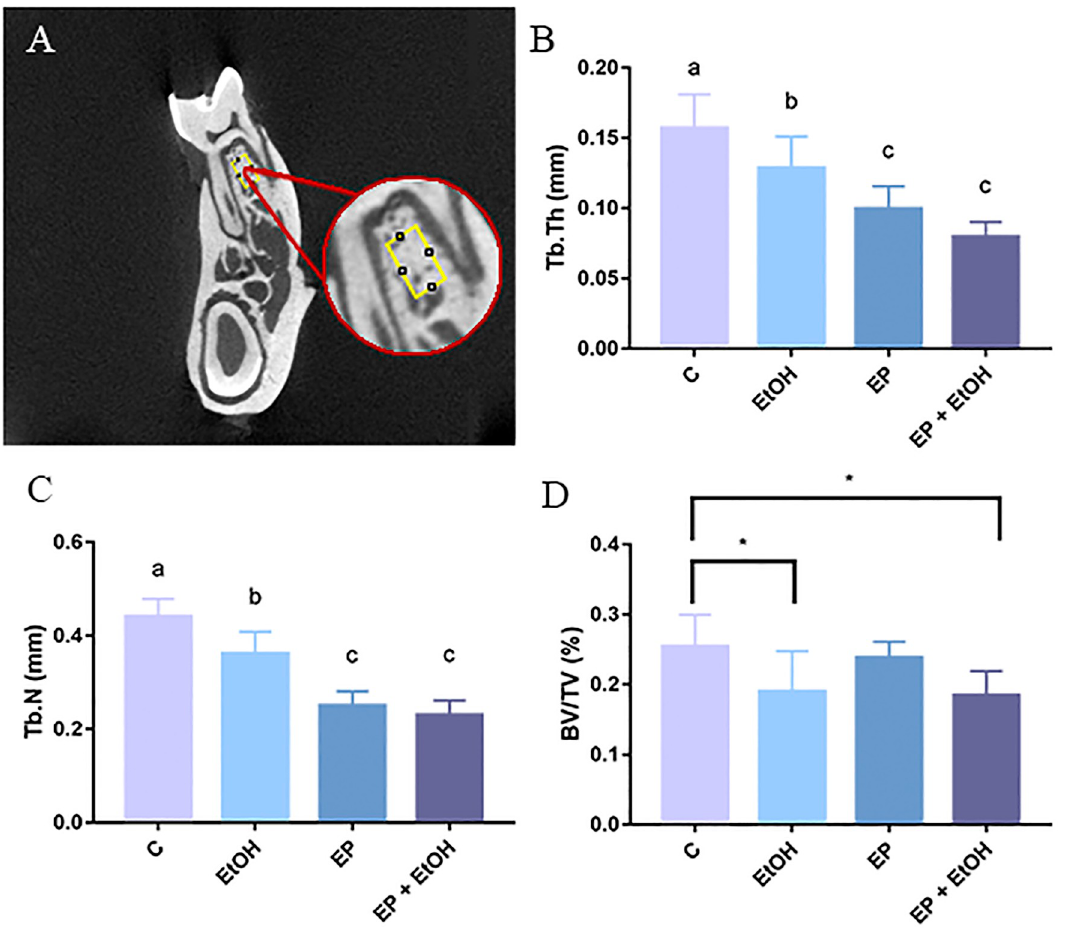
Fig 4. Results from the Micro-CT quality analysis. (A) Region of interest (ROI) used for evaluation. (B) Trabecular thickness parameter (Tb.Th) in all experimental groups. (C) Trabecular number parameter (Tb.N). For these results, same letters indicate no significant differences between groups (P < 0.05, ANOVA followed by Tukey post hoc test). (D) Bone density (%) parameter (BV/TV) obtained by micro-computed tomography (micro-CT). ( � ) indicates significant difference between the groups (p <